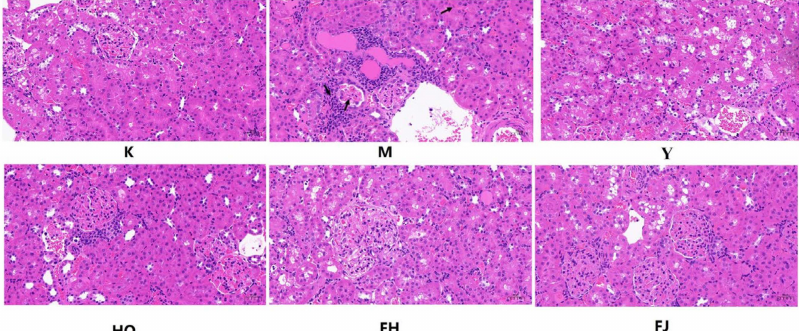
Figure 2. Hematoxylin-eosin (HE) staining was used to evaluate the pathological changes in renal tissue (Light microscopy, × 200): (K) control; (M) model; (Y) Huangkui capsule (Y, 1 g/kg); (FJ) Fang Ji (FJ, 4 g/kg); (HQ) Huang Qi (HQ, 5 g/kg); (FH) Fangji Huangqi herb couples (FH, 9 g/kg). Note: the black arrow indicates the location of the lesion.